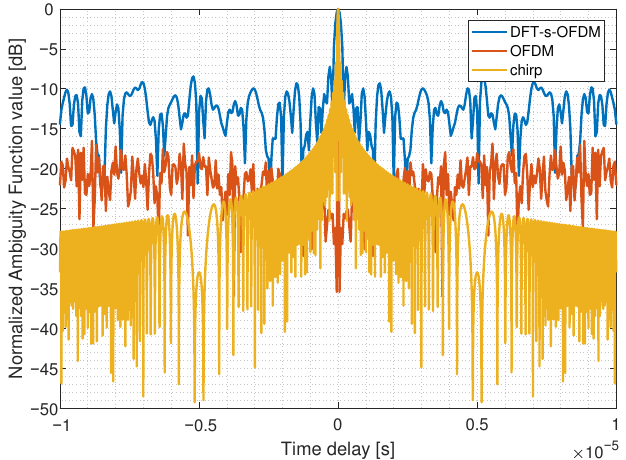
Figure 14. Comparison of ambiguity functions among DFT-s-OFDM, OFDM and